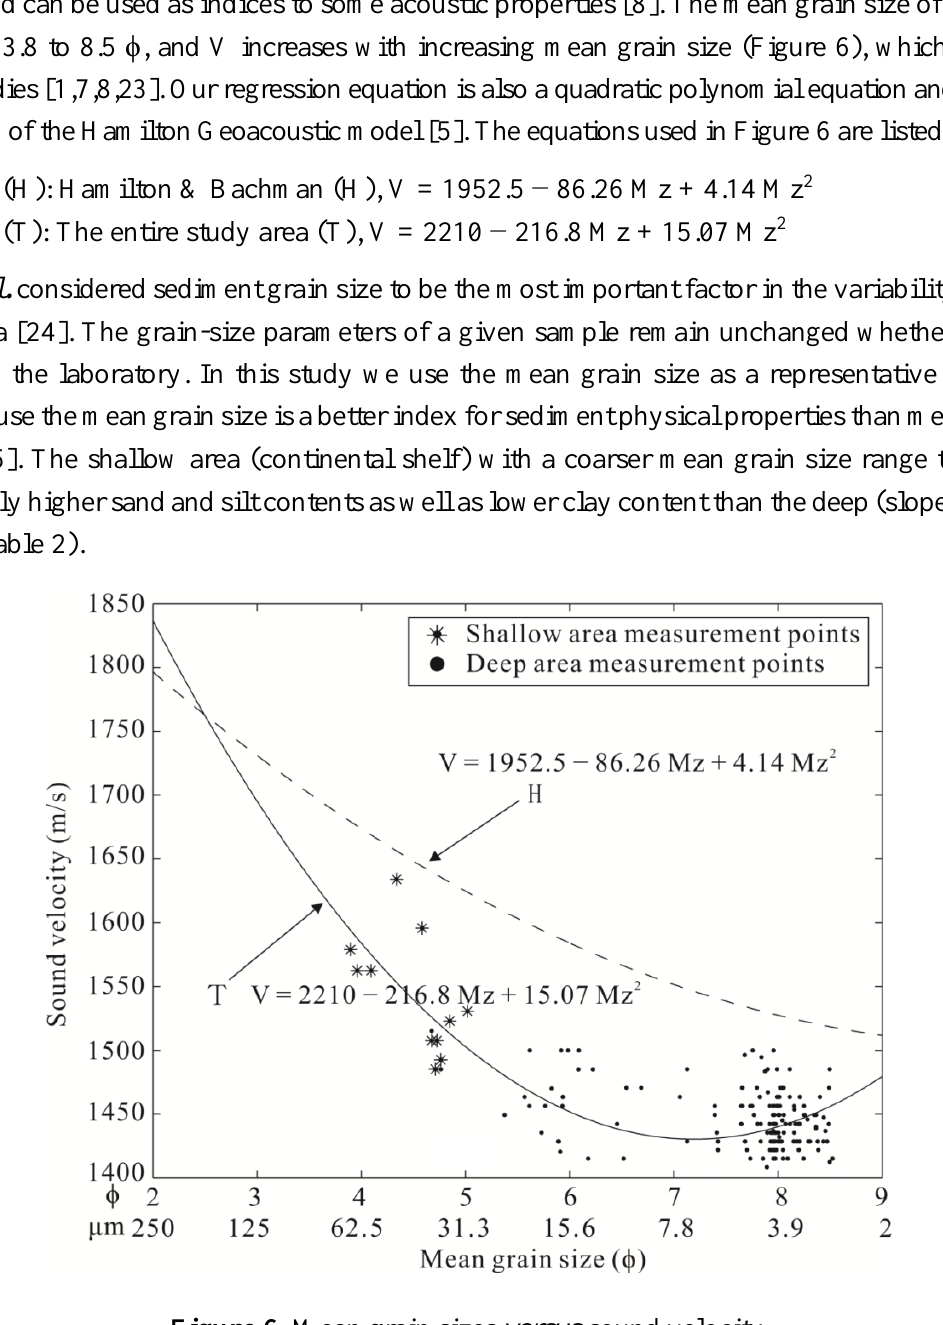
Figure 6. Mean grain sizes versus sound